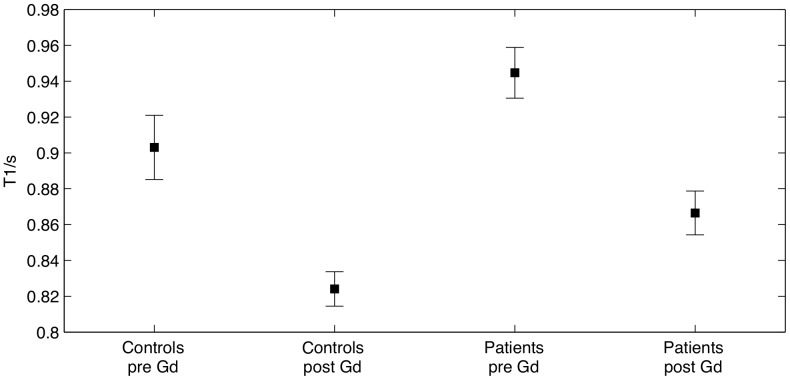
T1 values of the healthy controls and the patients.The plot shows mean T1 (s) and 95% confidence intervals. The injection of contrast agent significantly reduced T1 for both patients and controls. Compared to healthy white matter, the T1 value in NAWM of patients was higher both before and after the injection of contrast agent.